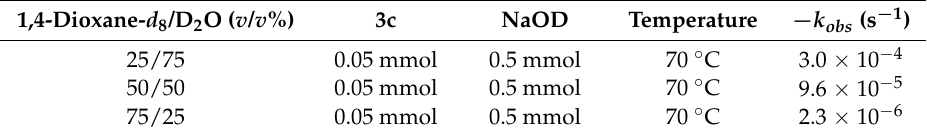
Table 1. Effect of variations of co-solvent proportions on the hydrolysis rate of 3c .